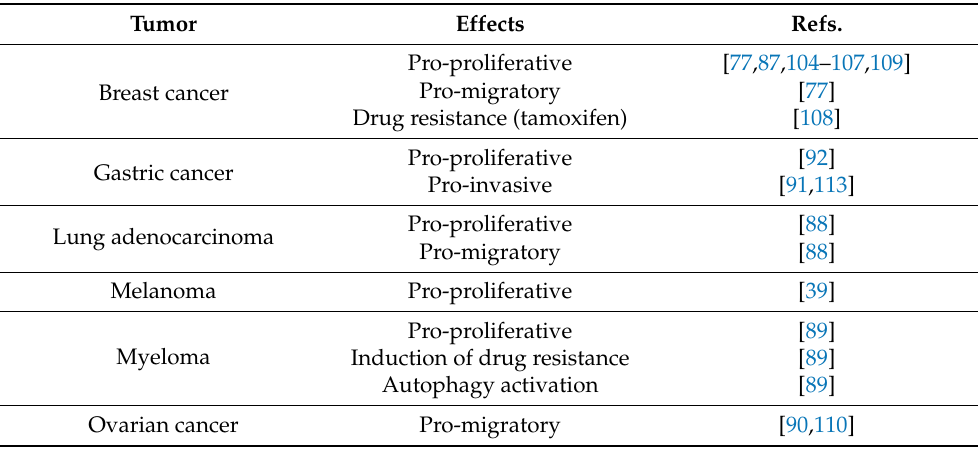
Table 1. HSPB8 pro-tumoral